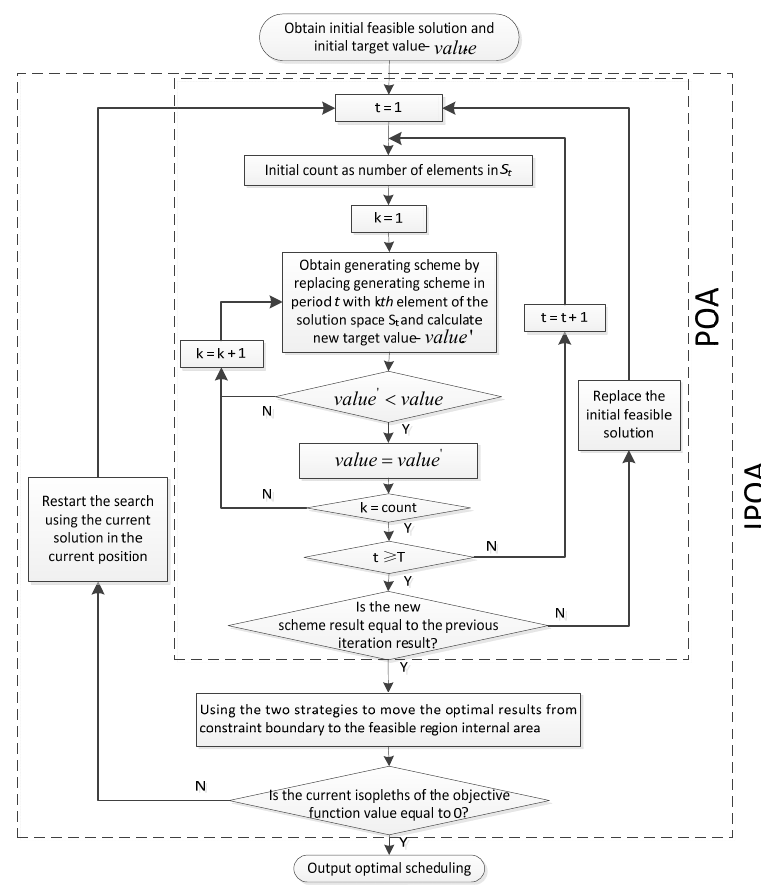
Figure 6. Solution flowchart of medium ‐ term optimal commitment of thermal units (MOCTU) by improved progressive optimality algorithm (IPOA).